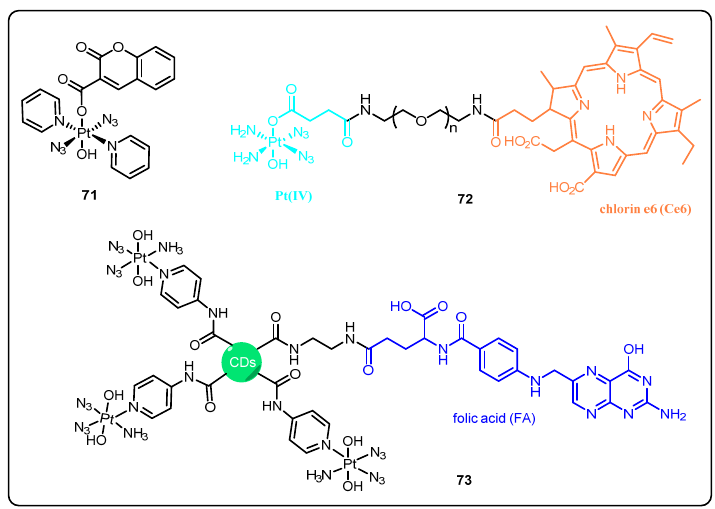
Figure 9. Diazido platinum(IV) complexes developed as anticancer